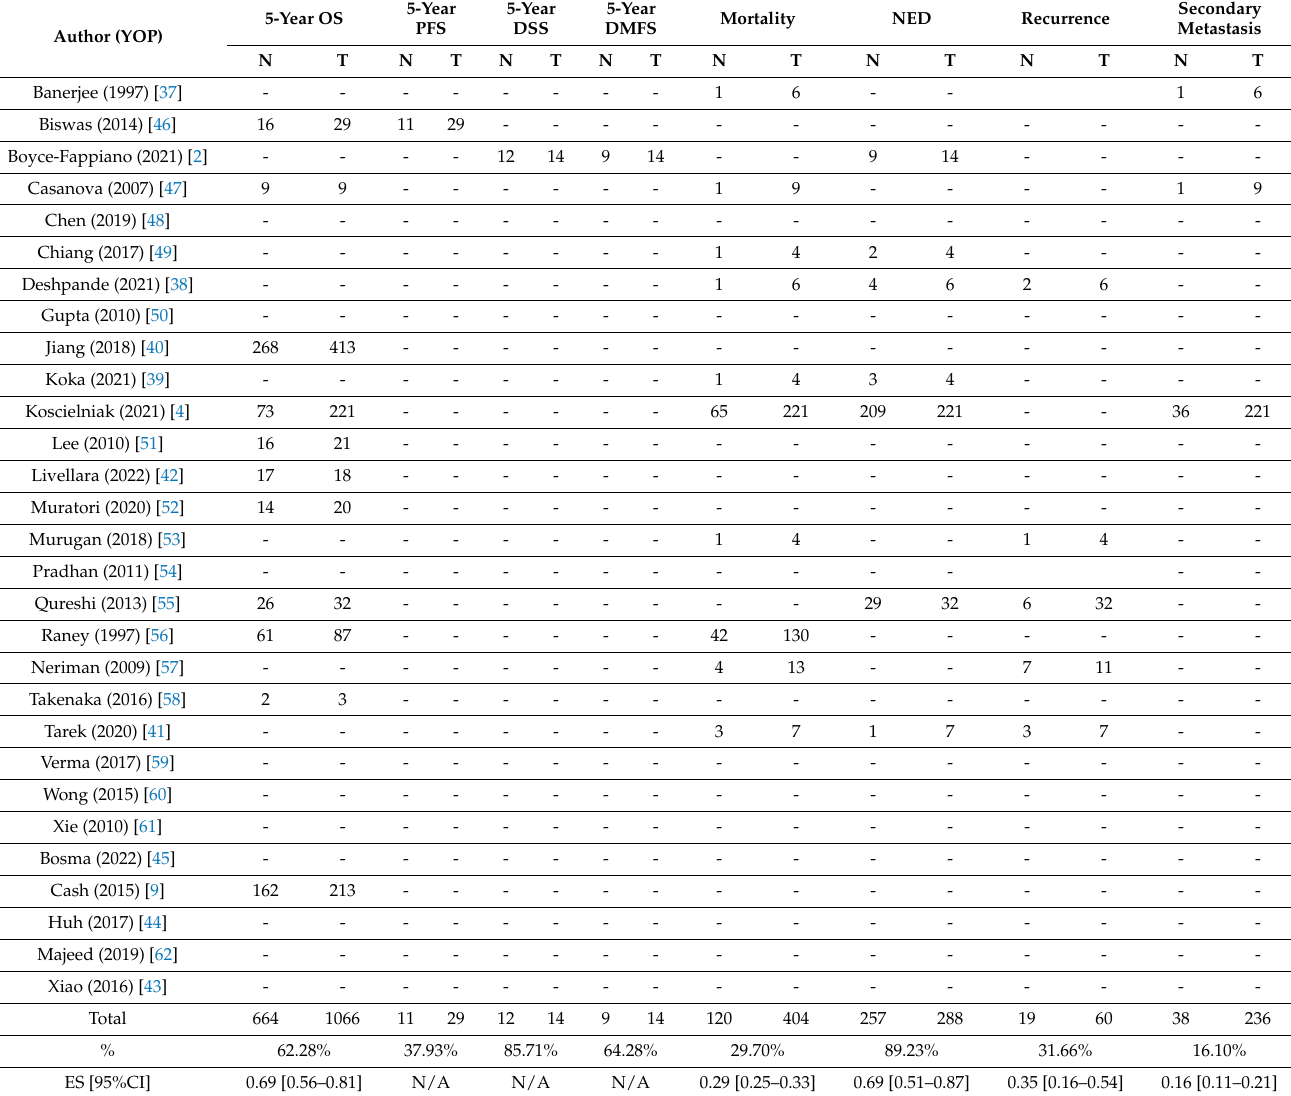
Table 5. The clinical outcomes of pediatric patients with extraosseous Ewing